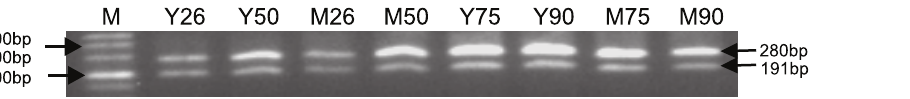
Figure 2. RT-PCR analysis of NNAT mRNA in different placentas of different breeds and at different developmental stages. The 280 base pair NNAT - a sequence and the 199 base pair NNAT - b sequence were both detected in all samples. From left to right, the lane contents were as follows: 500 base pair DNA ladder (Takara), products amplified from the placentas of Yorkshire pigs on day26 and d50 of gestation, Meishan pigs on day26 and day50 of gestation, Yorkshire pigs on day75 and d90 of gestation, and Meishan pigs on day75 and d90 of gestation.